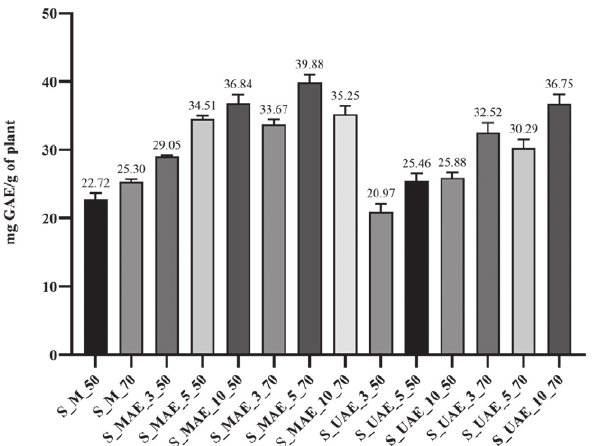
Figure 2. Total polyphenol content of S. officinalis extracts (Data are expressed as mean ±SD values from independent triplicate